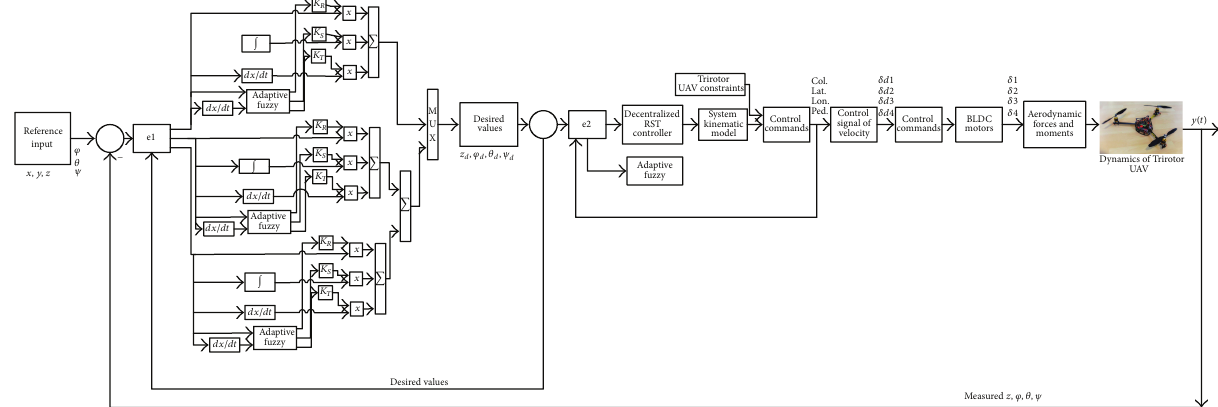
Figure 8: Simulink Matlab base block diagram of fuzzy RST controller.